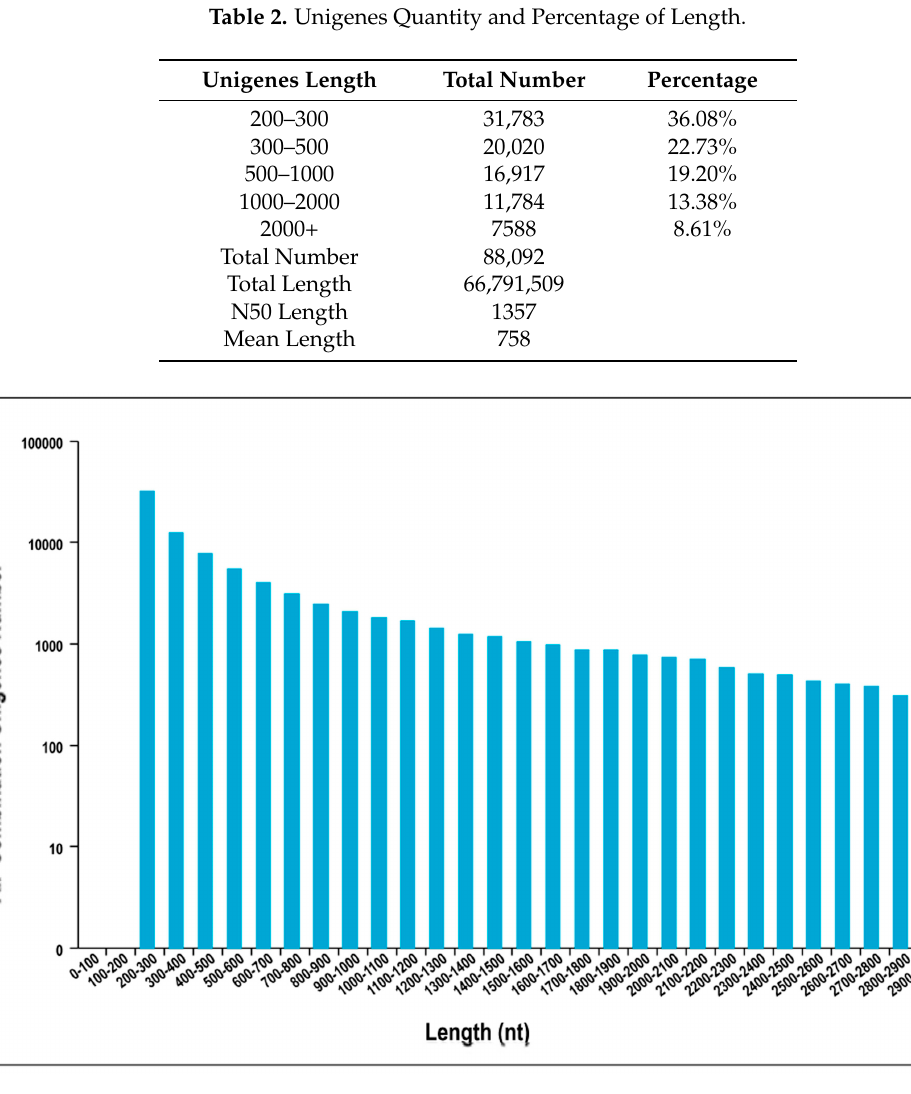
Figure 2. The length distributions of the unigenes.